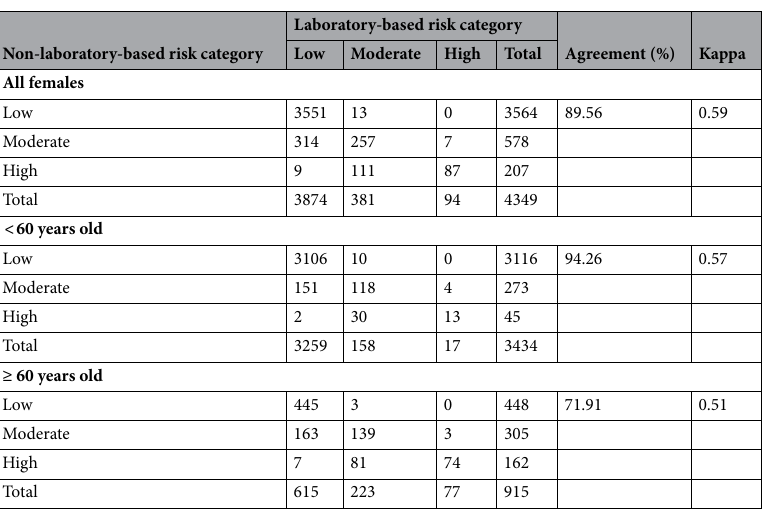
Table 3. Agreement between the laboratory-based and non-laboratory-based risk scores according to the grouped risk in females.